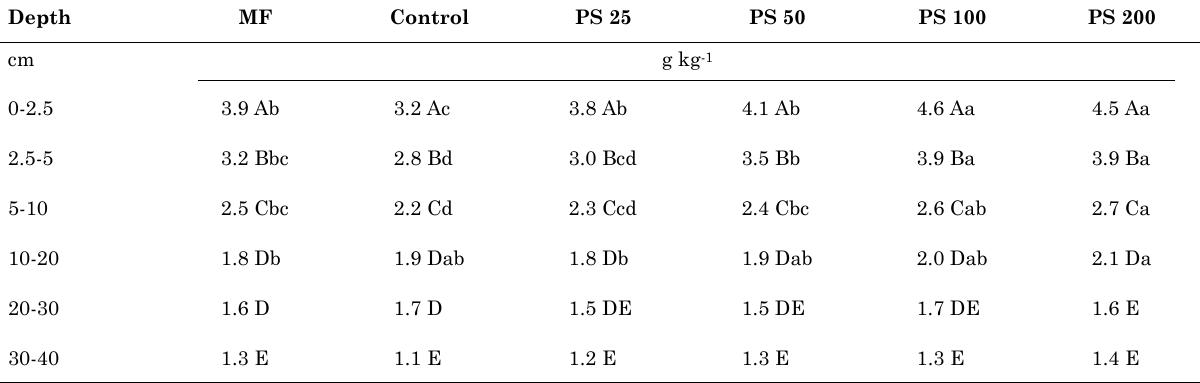
Table 4. Total nitrogen content (Tn) in layers up to 40 cm in a latossolo Vermelho distroférrico (Typic Hapludox), subjected to 10 years of annual fertilization with mineral fertilizer (mF) and pig slurry (PS) at the rates of 0 (control), 25, 50, 100, and 200 m 3 ha -1 in a no-till system. mean values of four replications Depth